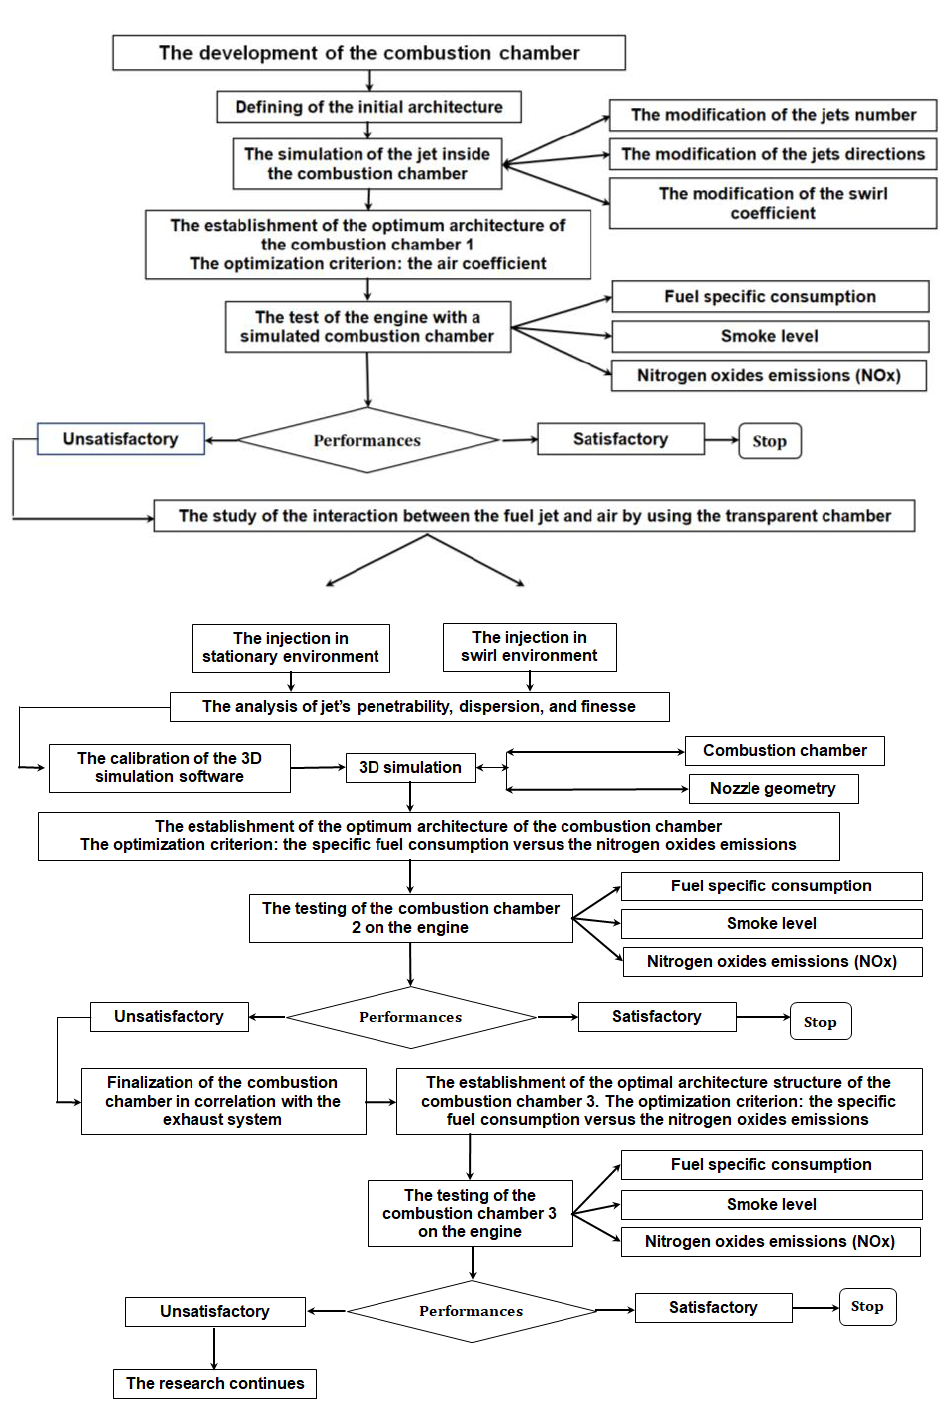
Figure 6. The research scheme for the combustion chambers.